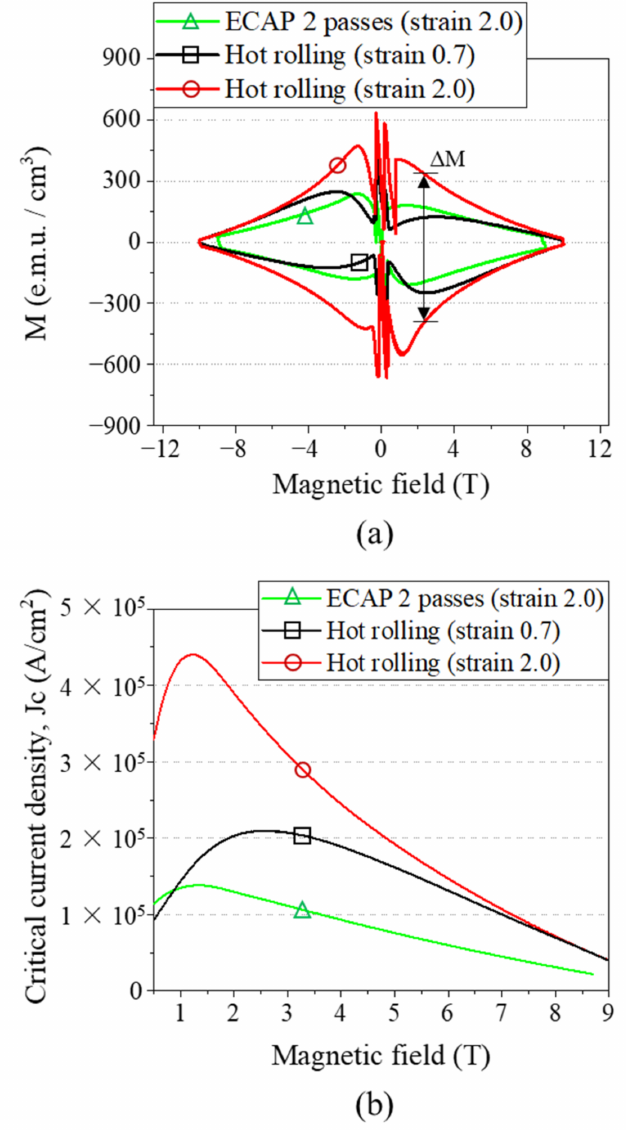
Figure 7. ( a ) Normalized moment according to initial process conditions and ( b ) calculated critical current